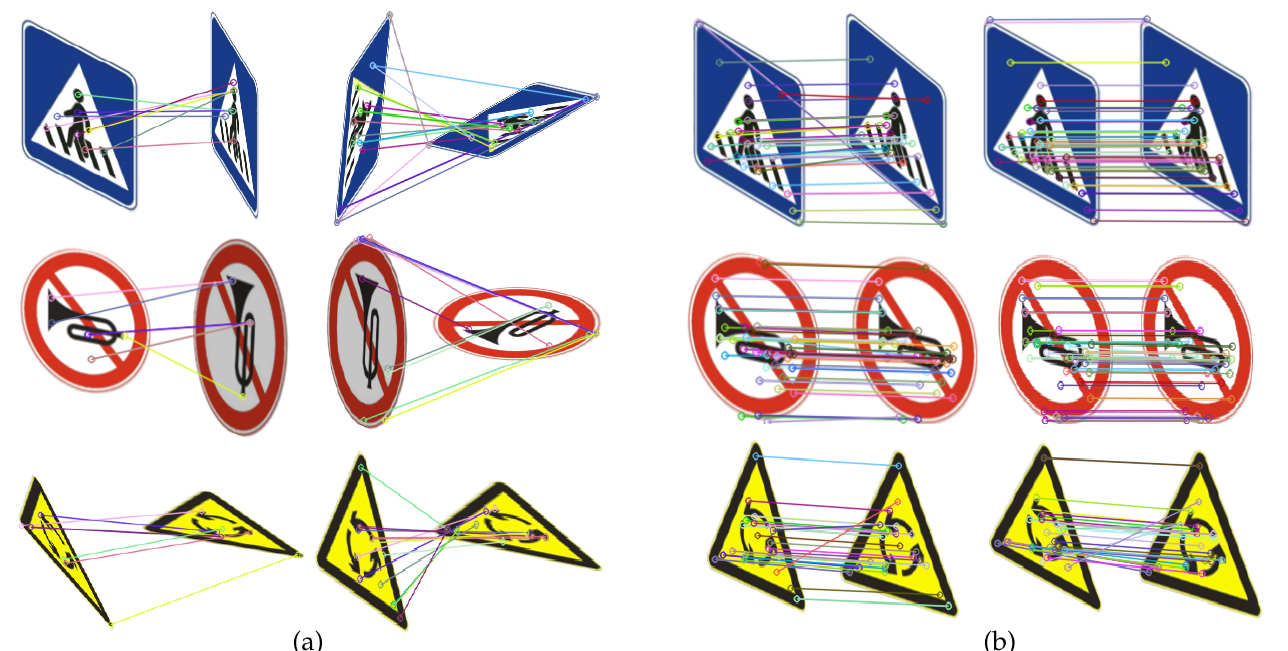
Figure 14. Corresponding points: grouping images before matching. ( a ) Corresponding points extracted from road signs with different shooting angles. ( b ) Corresponding points extracted from road signs with similar shooting angles.